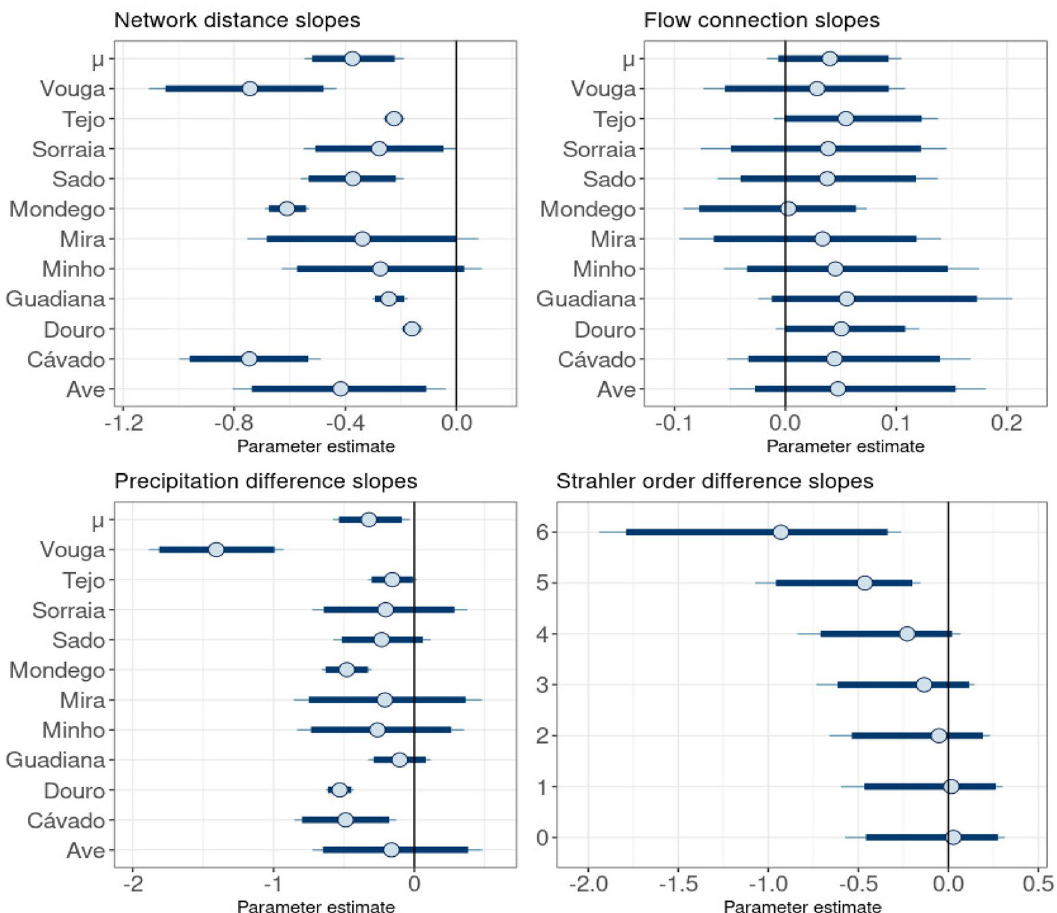
where slopes are sampled. Dark blue lines represent 95% credibility intervals. The thin light blue line represents the complete distribution of the parameters. The dot represents the marginal posterior